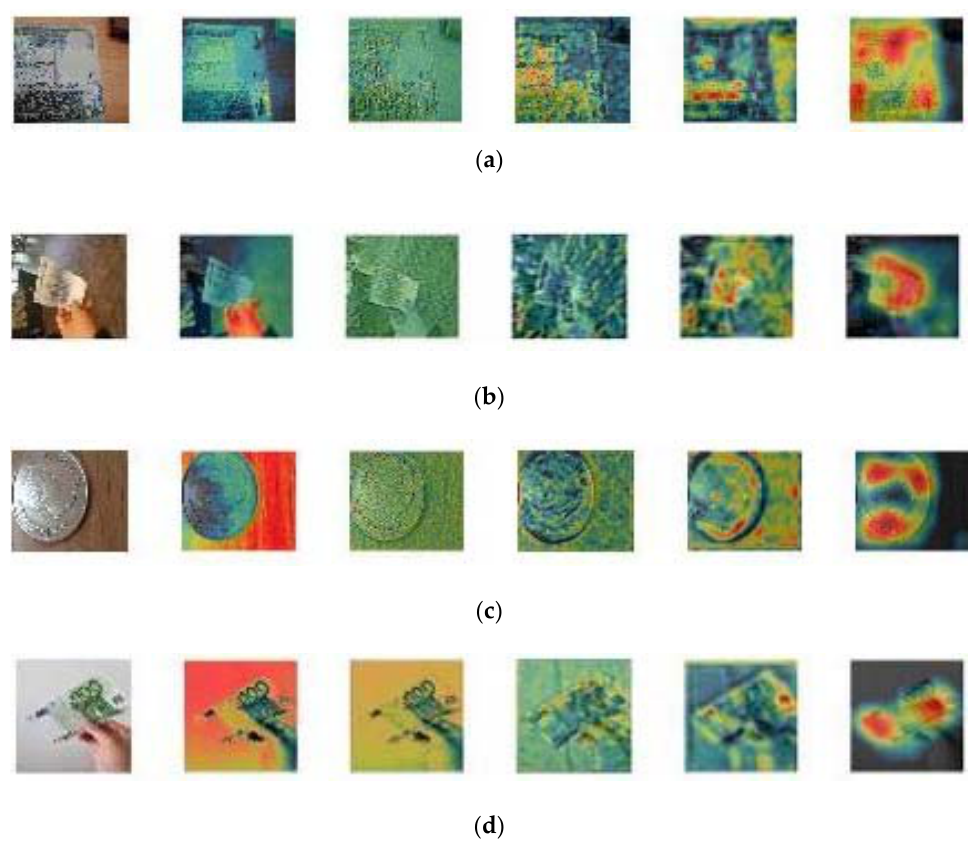
Figure 13. Examples of GradCAM images from MBDM, ( a – d ) are with the inputs of JOD 20 dinar, KRW 1000 bill, JOD 5 dinar coin, and EUR 100 bill, respectively. GradCAM images extracted from input, conv_8, conv_12, conv_16, conv_20, conv_24 of Table 2 from the left of ( a – d